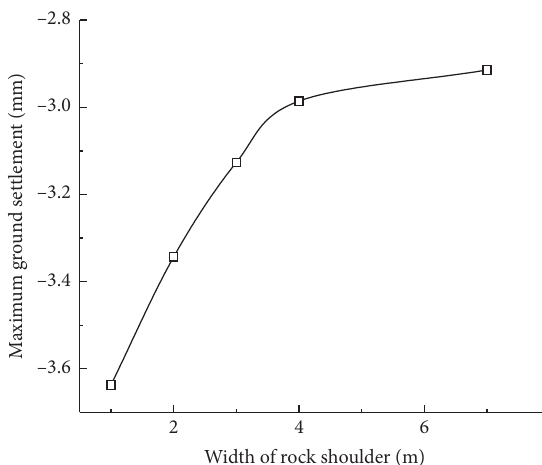
Figure 17: Influence of rock-socketed depth on maximum land subsidence.